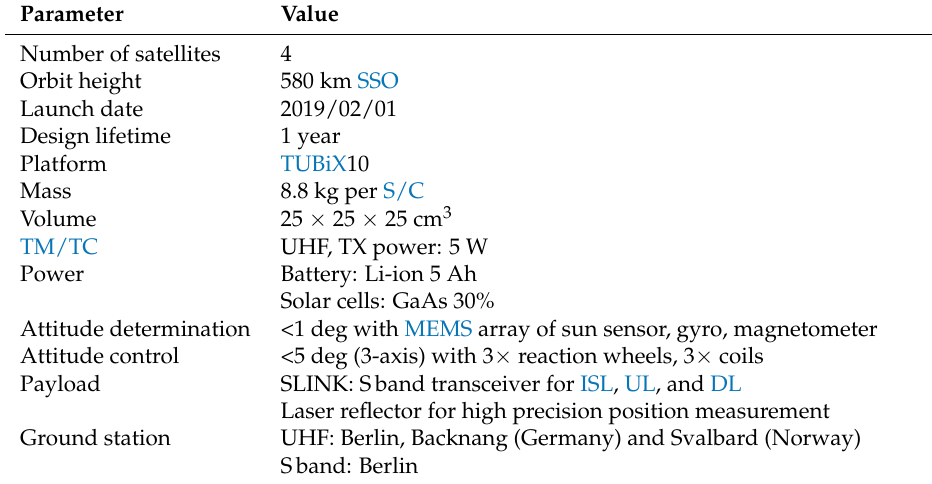
Table 8. Overview of S-NET